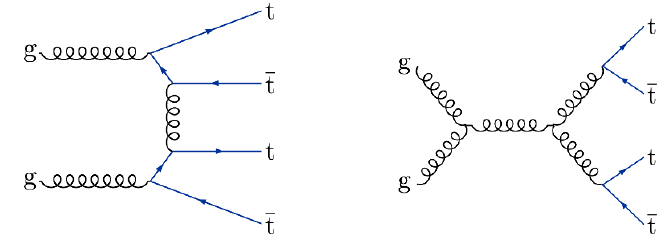
Figure 1 . Representative Feynman diagrams for pp ! tttt production at lowest order in the SM. of (cid:27) SM = 9 : 2 fb is used [12, 13]. Consequently, the experiments at the CERN LHC tttt